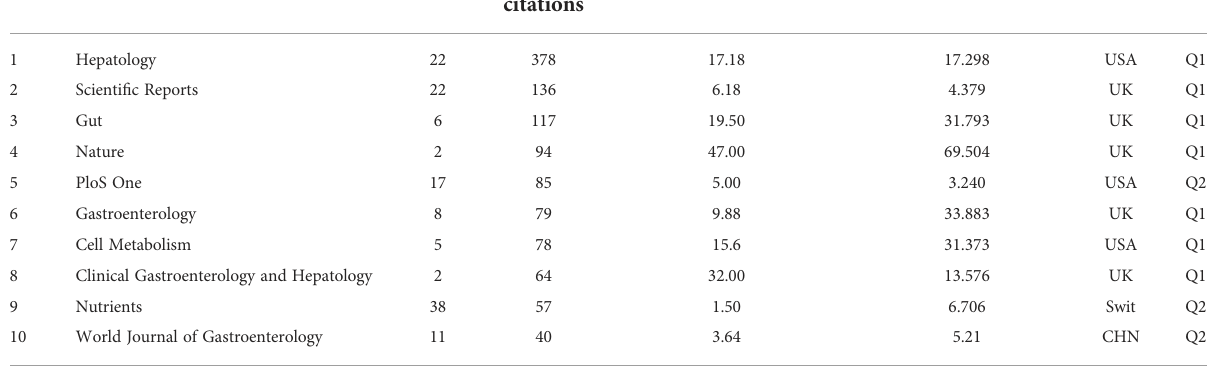
TABLE 1 The top 10 most active journals that published articles in the links of gut microbiota and MAFLD research from 2002 to 2021 (sorted by total citation). Rank